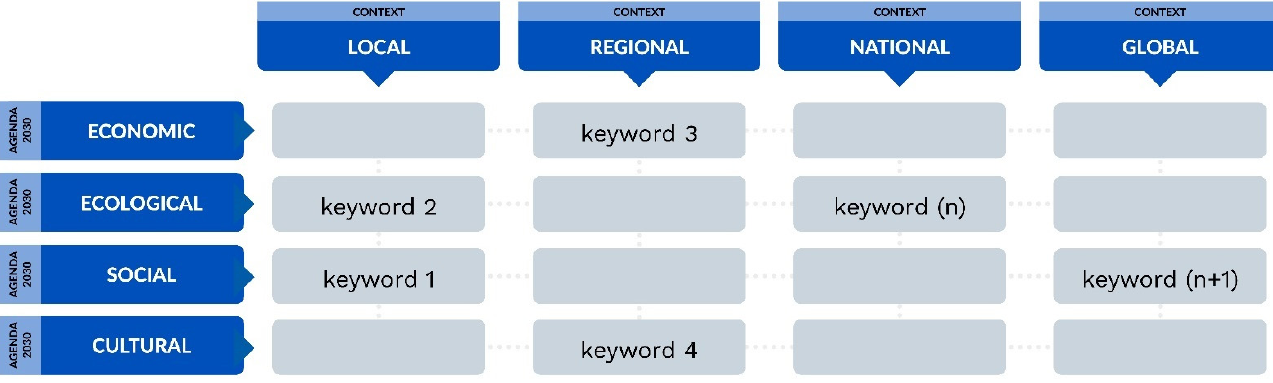
Figure 3. In Step 3, the researched phenomenon is investigated in relation to different dimensions of sustainability, and to their